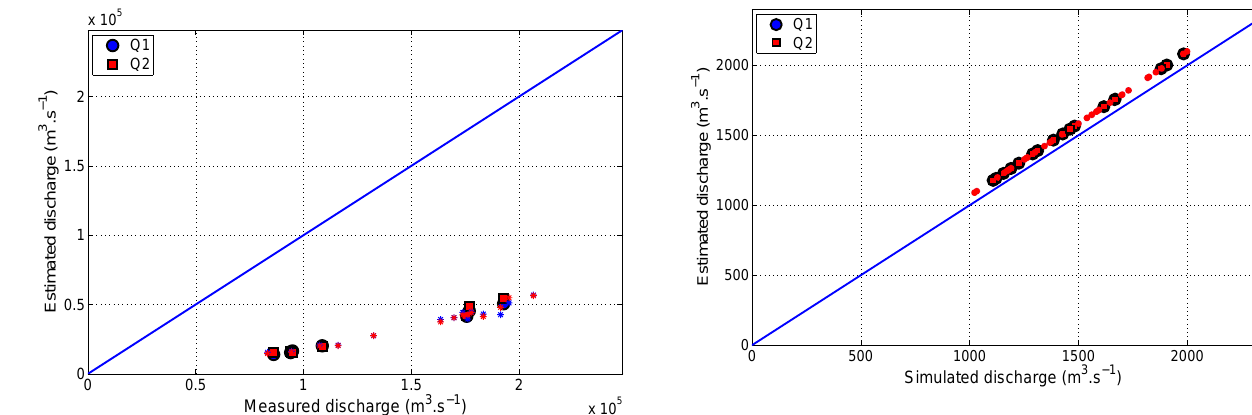
For the simulated dataset, as all the virtual measurements are perfectly aligned, the different calibration sets led to the same results in all